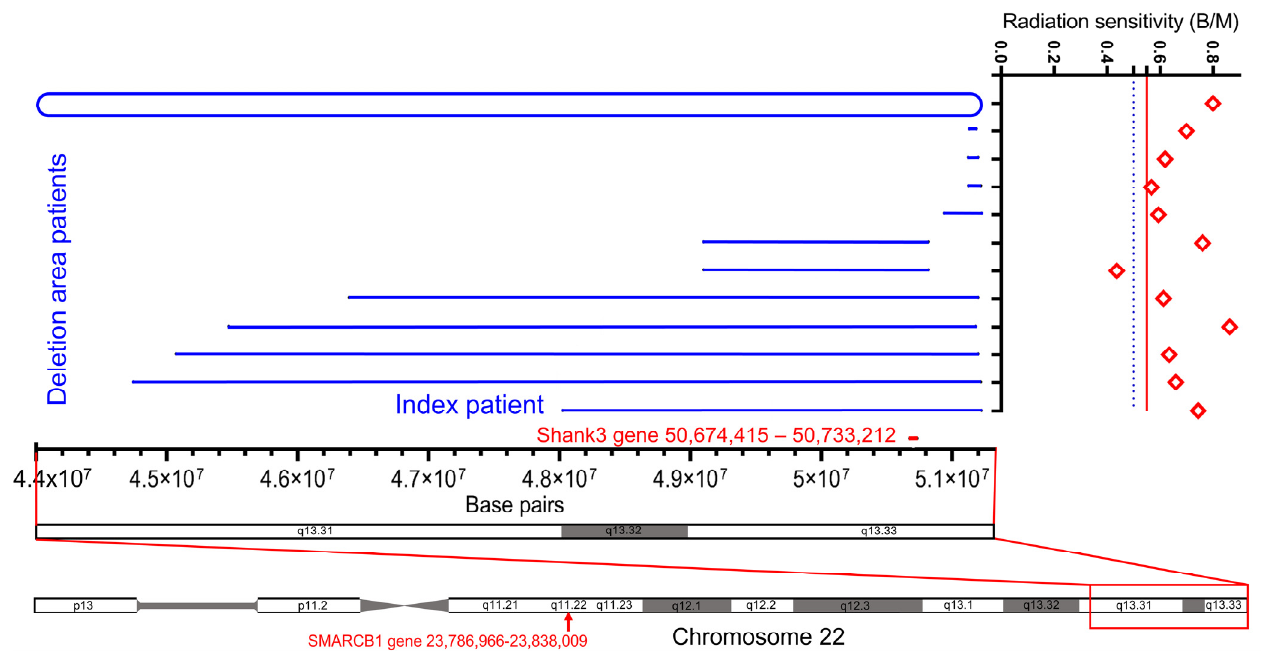
Figure 4. Deletion regions of chromosome 22 in 12 PMS patients and their radiation sensitivity expressed as breaks per metaphase. The entire chromosome and a subsection (red box) of chromosome 22 are indicated. The location of the SHANK3 gene is indicated as a short red line. The blue lines indicate the length of deletions in 11 individuals. The upper closed line indicates an individual with a ring chromosome. Radiation sensitivity of individuals is indicated in the right column. The dashed blue line indicates individuals with increased radiation sensitivity, and the solid red line indicates individuals with significantly increased radiation sensitivity. Loss of function of the SMARCB1 gene (red arrow) and its product, the tumor suppressor protein INI1, is associated with tumor incidence and, in particular, with atypical teratoid/rhabdoid tumors.